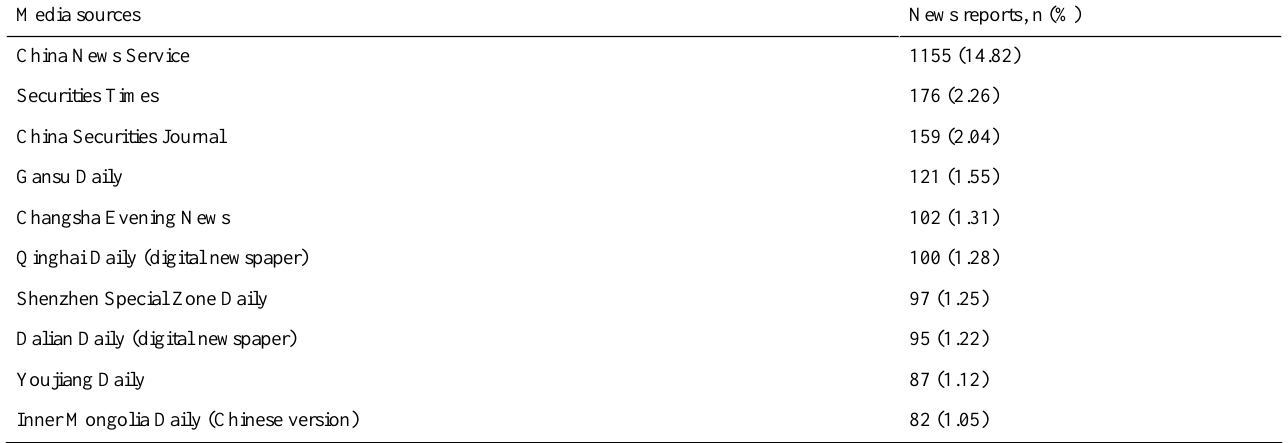
Table 2. The most represented media sources for the collected news reports